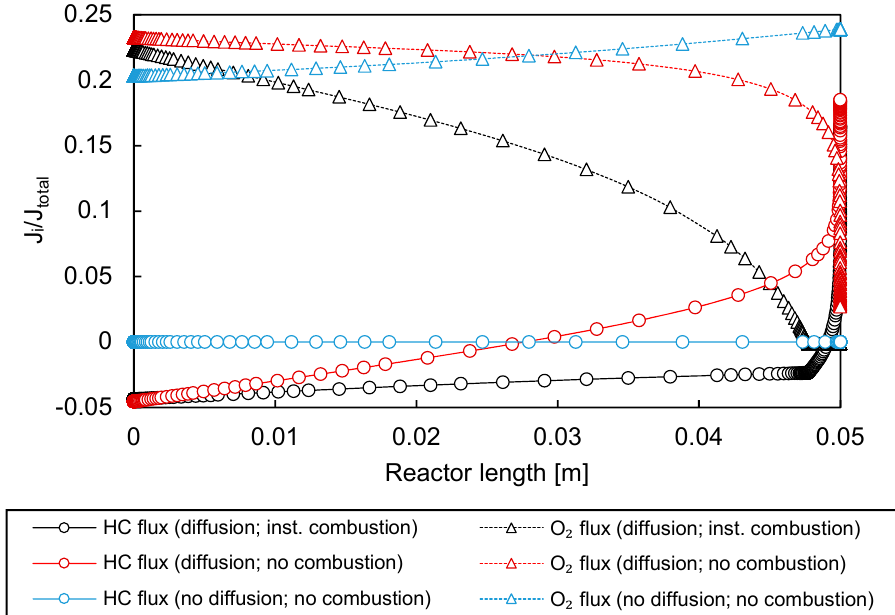
Figure 10. Normalized oxygen and hydrocarbon (HC) fluxes obtained from the 1D PBMR model for three cases: just convection (blue), convection and diffusion (red), and convection, diffusion, and combustion in the retentate side (red).